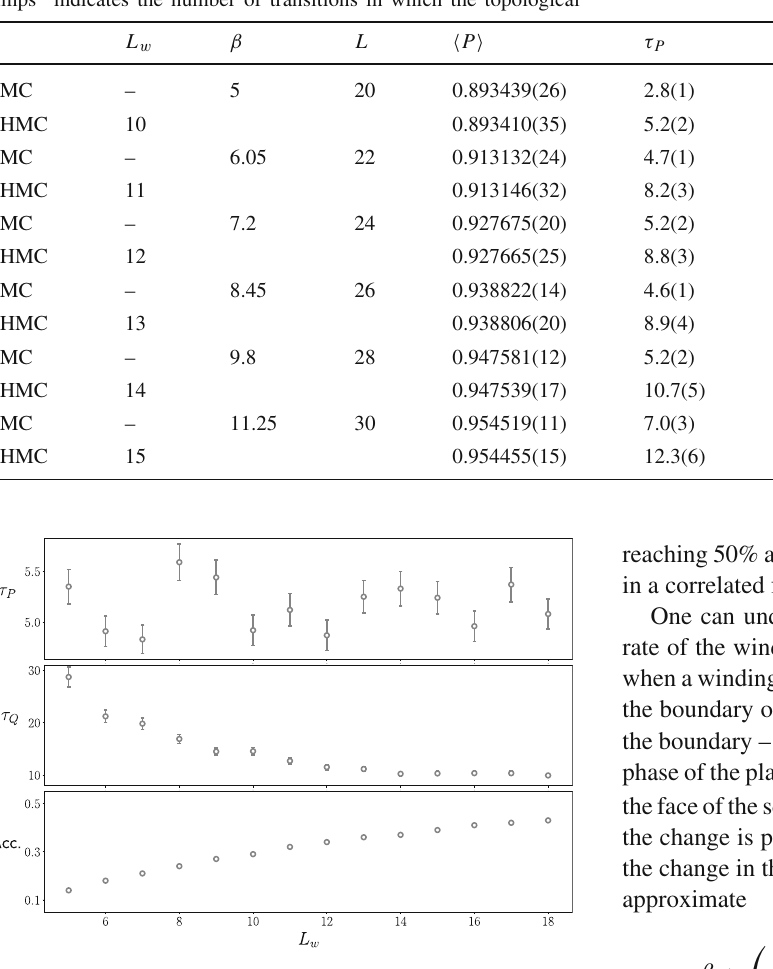
charge changes by at least one unit. The integrator of the HMC step is tuned such that the acceptance is ∼ 90%